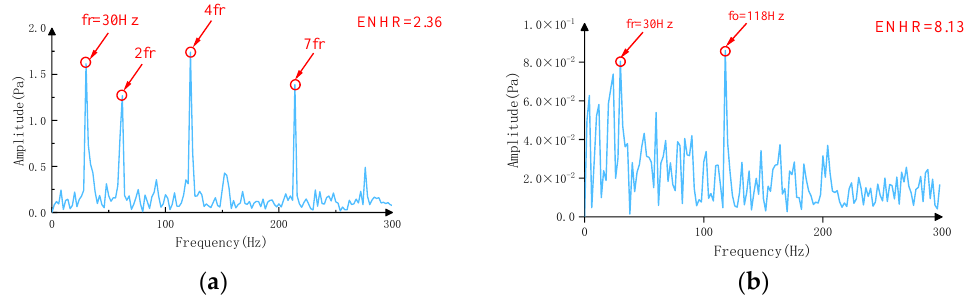
Figure 7. The waveform of ( a ) the first microphone original signal and ( b ) the fused signal.